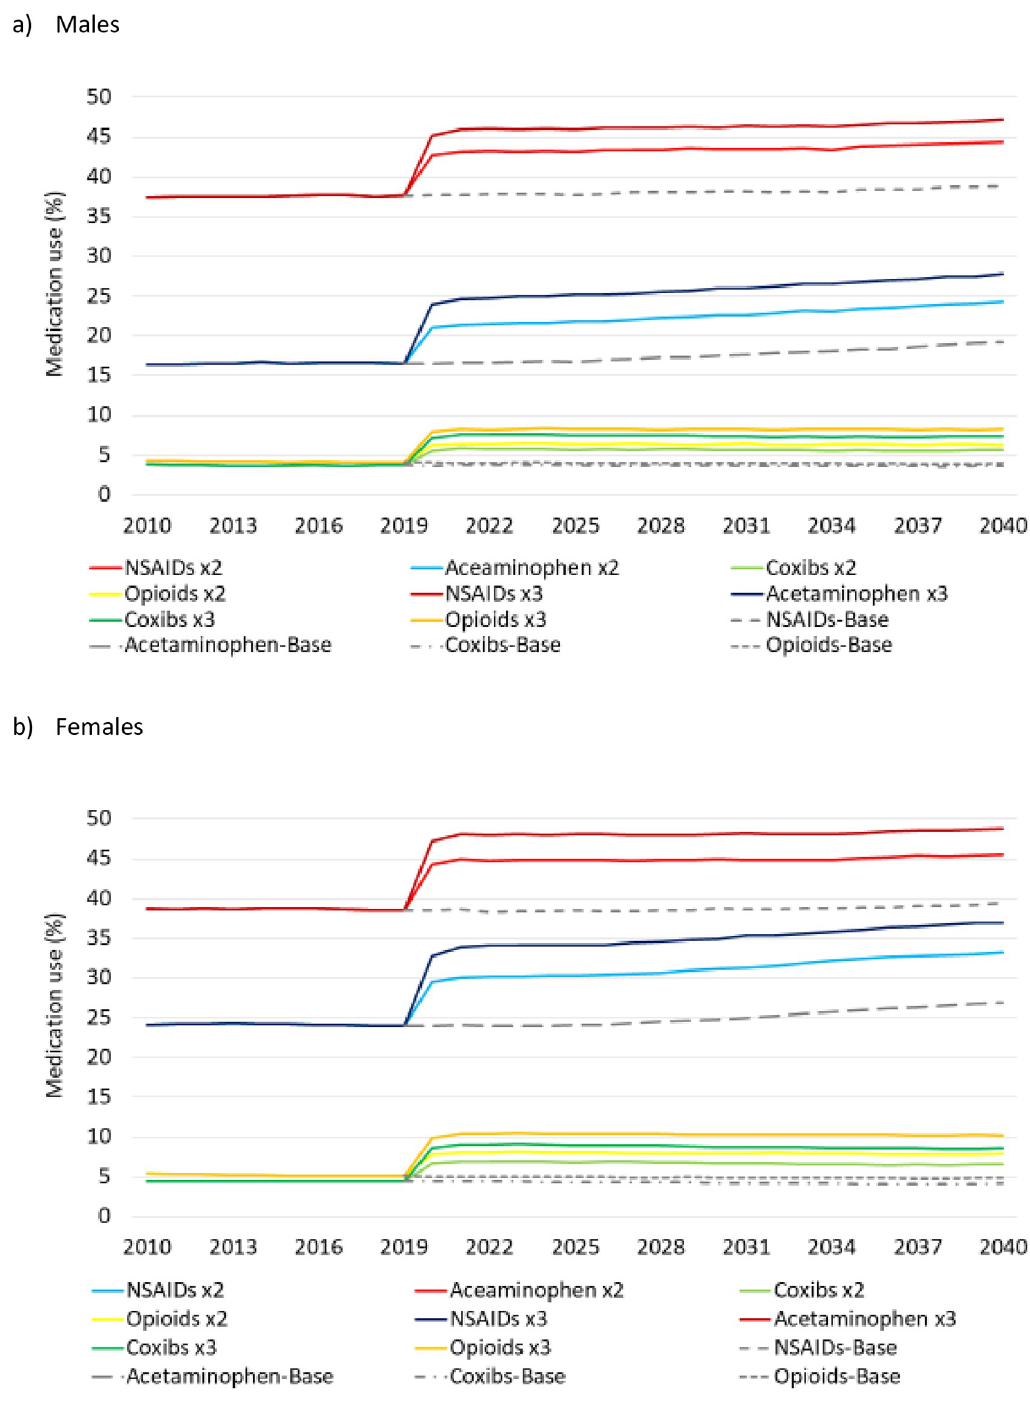
Fig 1. Use of four classes of analgesics before and after Medication x2 and Medication x3 interventions in people with osteoarthritis. All interventions are described in Table 1.